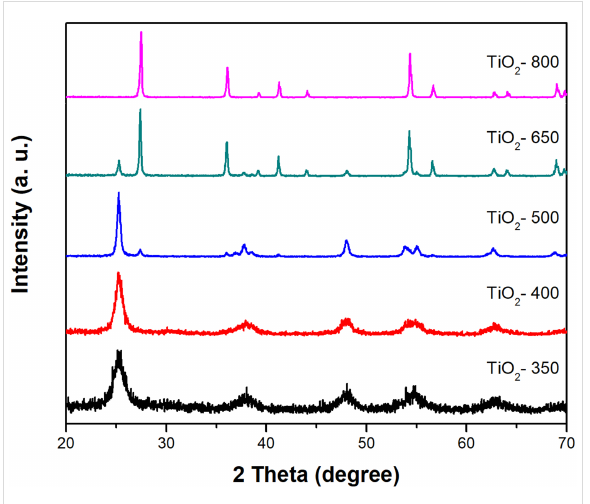
Figure 4: X-ray diffraction patterns of TiO 2 particles calcined at differ- ent temperatures ( ≈ 350–800